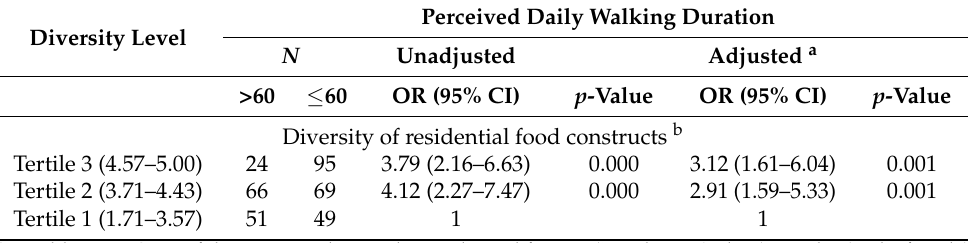
Table 5. Logistic regression analysis for the association between the diversity of residential food environment variables and perceived daily walking